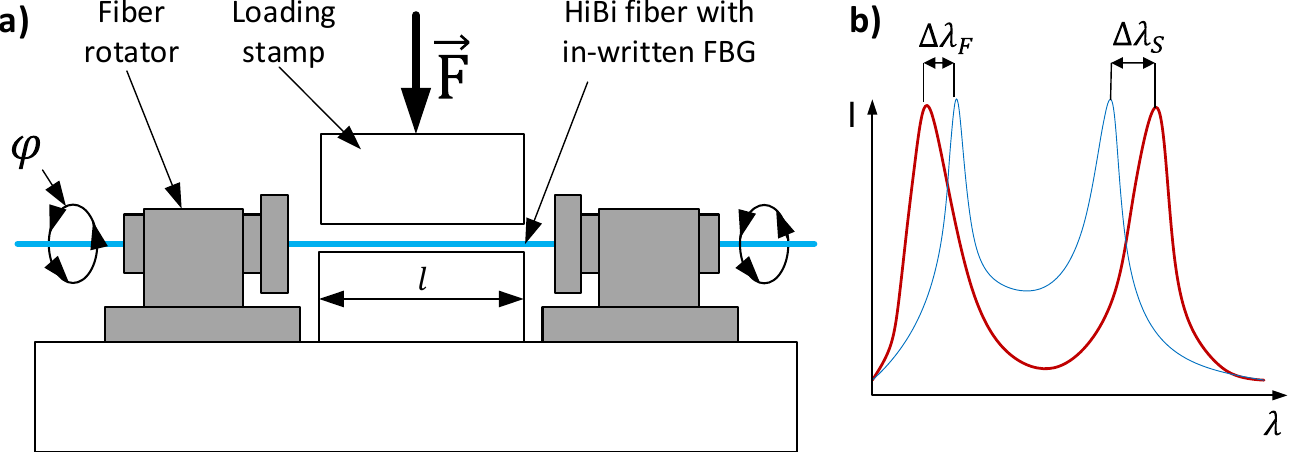
Figure 1. Testing of an HB FBG sensor; ( a ) a scheme of testing, ( b ) variation in Bragg wavelengths due to external force.